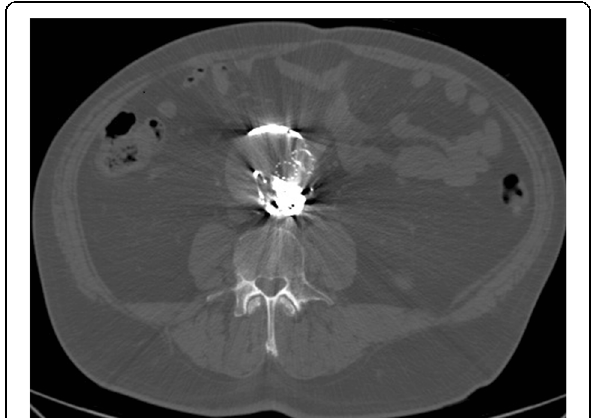
Fig. 4 Post-embolization axial CTA through the lower abdomen at the same level as image in Fig. 1 shows embolic material filling the portion of the aneurysmal sac which previously demonstrated